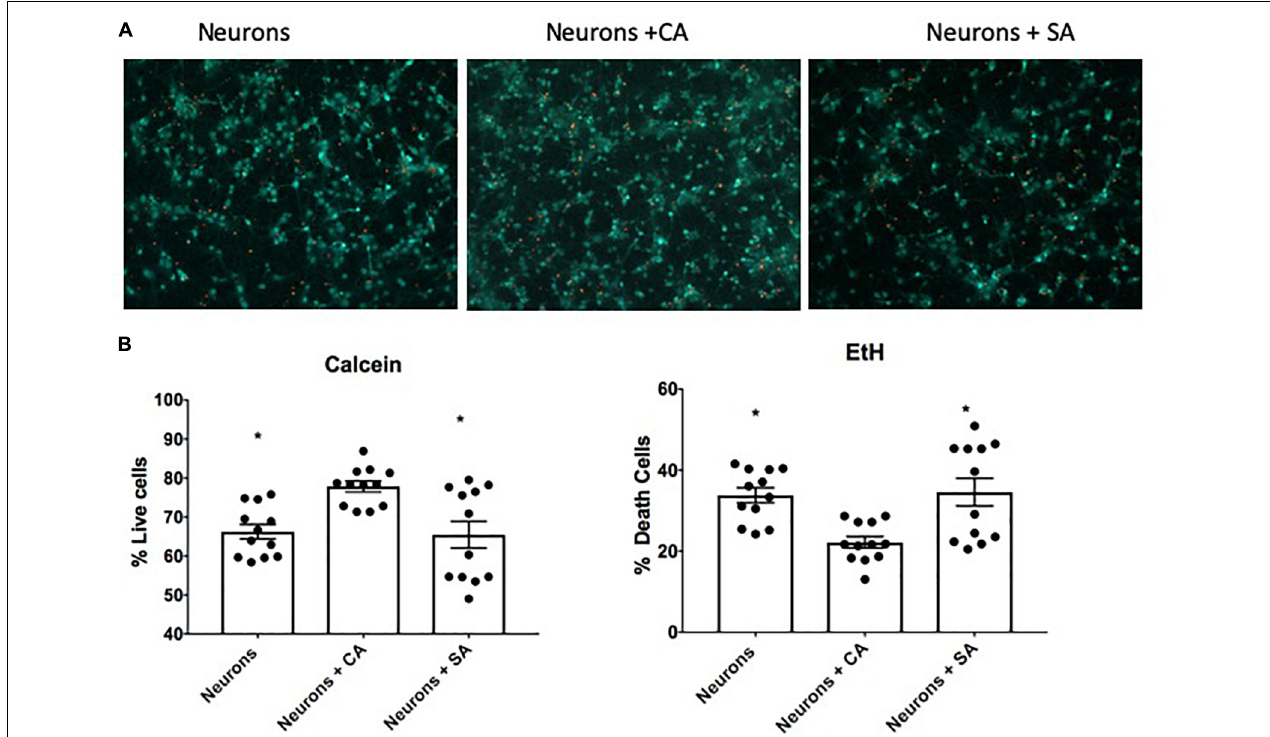
FIGURE 2 | Neuronal viability. (A) Representative images of the live-death assay by using calcein and ethidium homodimer. Neuronal viability was assessed at 12 DIV after being alone or in coculture with senescent astrocytes (SA) and control astrocytes (CA). (B) Percentage of living (calcein-positive cells) and death (EtH-positive cells). Each bar represents the mean ± SD; n = 3 for each group. Significant differences were tested by the ANOVA and the Tukey–Kramer test, * p ≤ 0.05 vs. neurons +